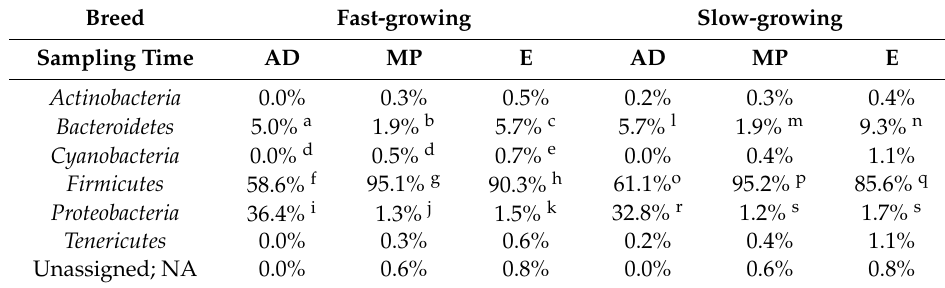
Table 4. Taxonomic profiles at phylum level according to management system (FG or SG) and sampling moment based on MetagenomeSeq parametric